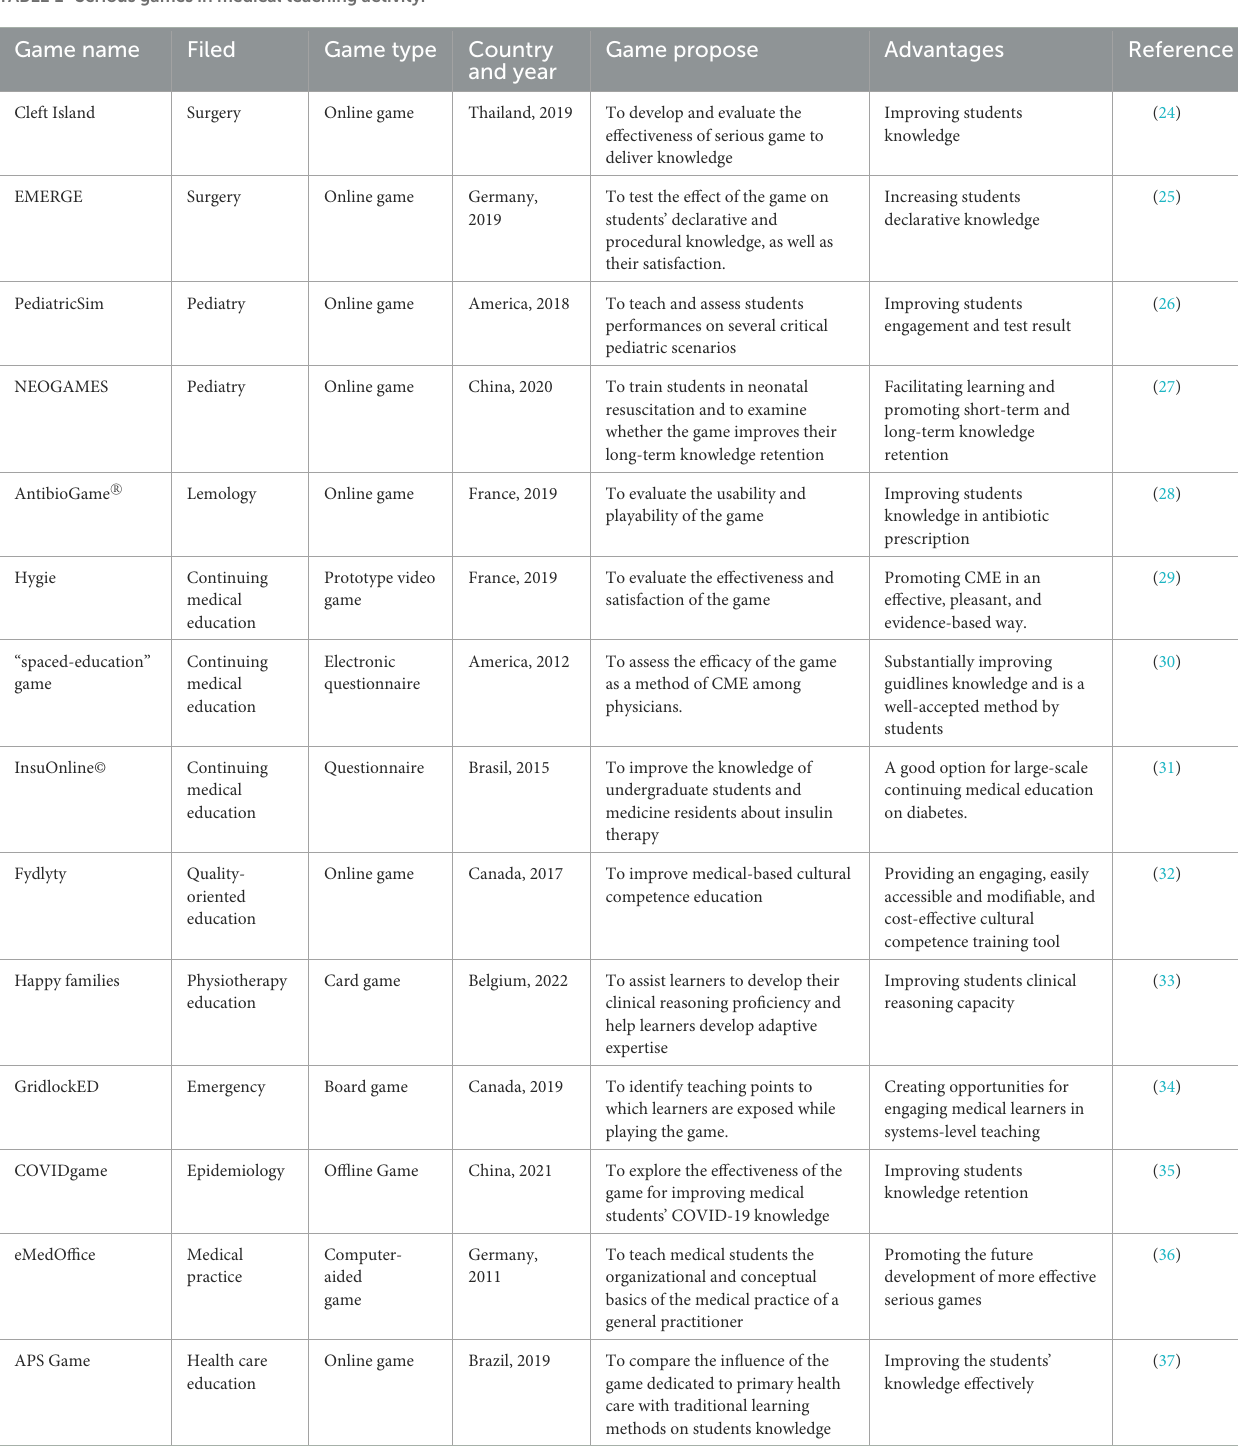
TABLE 1 Serious games in medical teaching